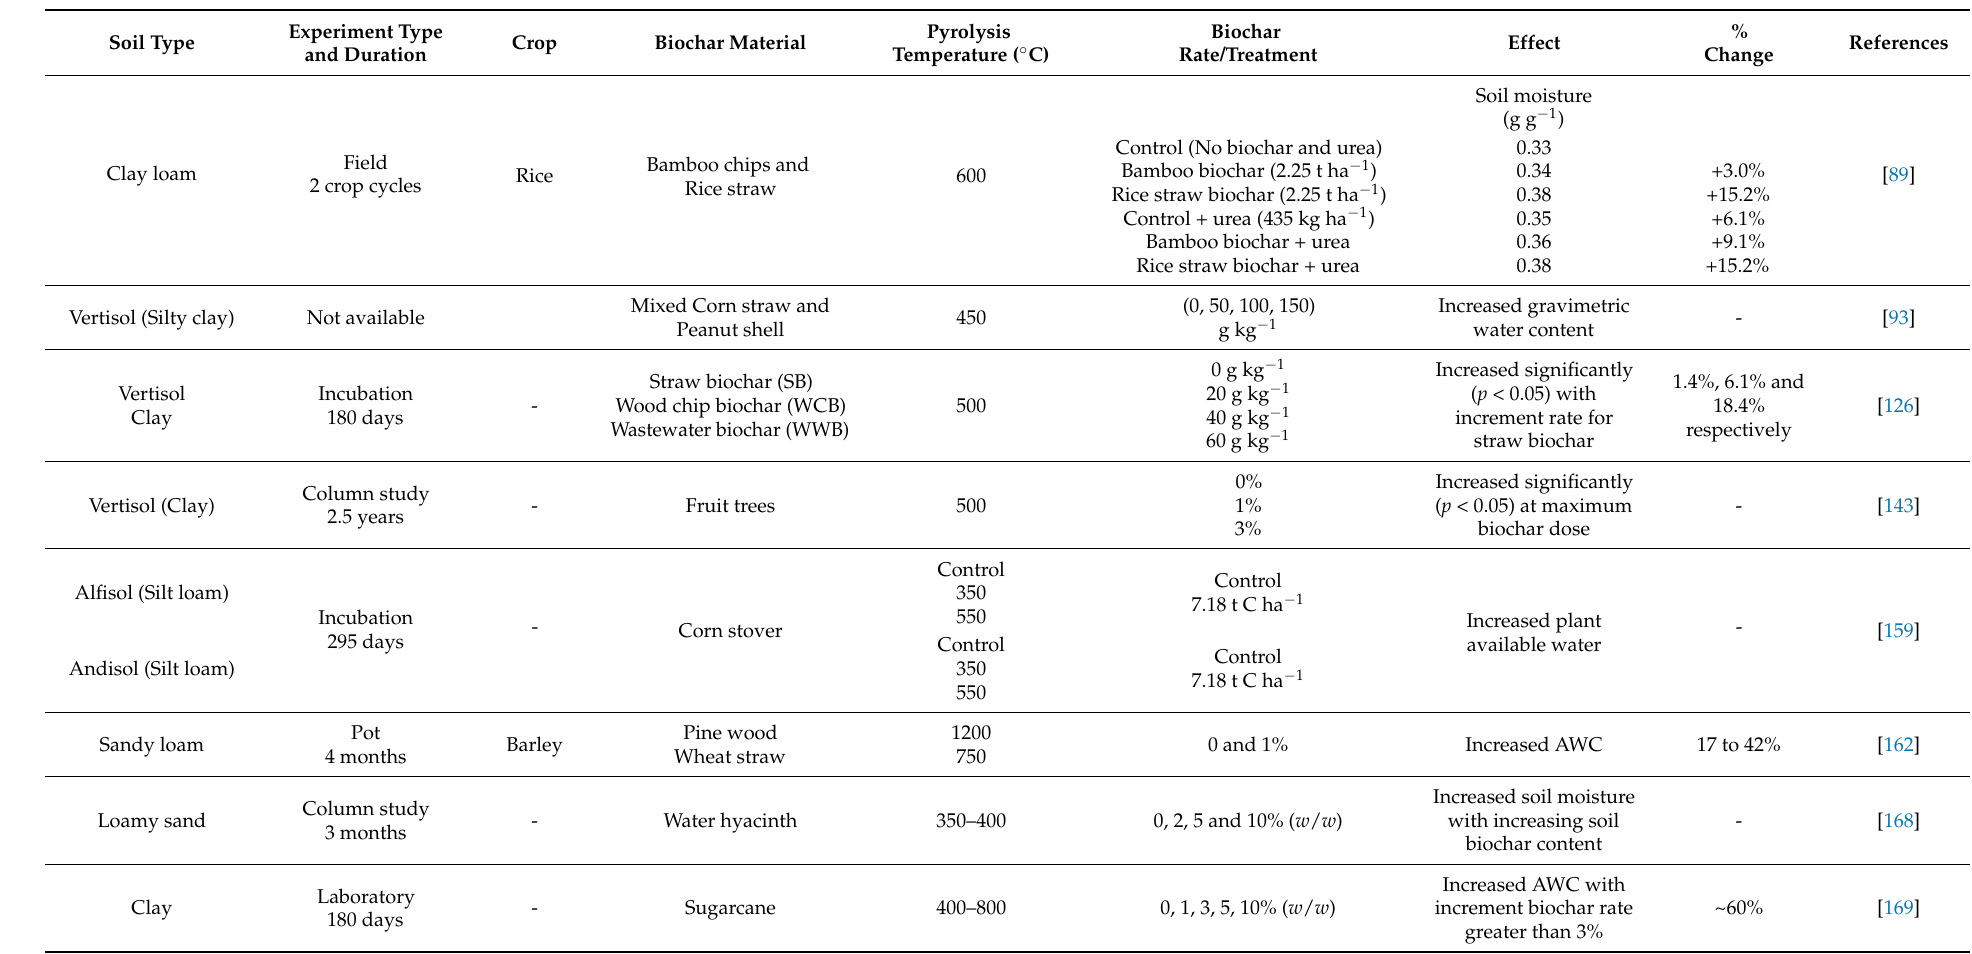
Table 9. Soil moisture retention properties influenced by biochar